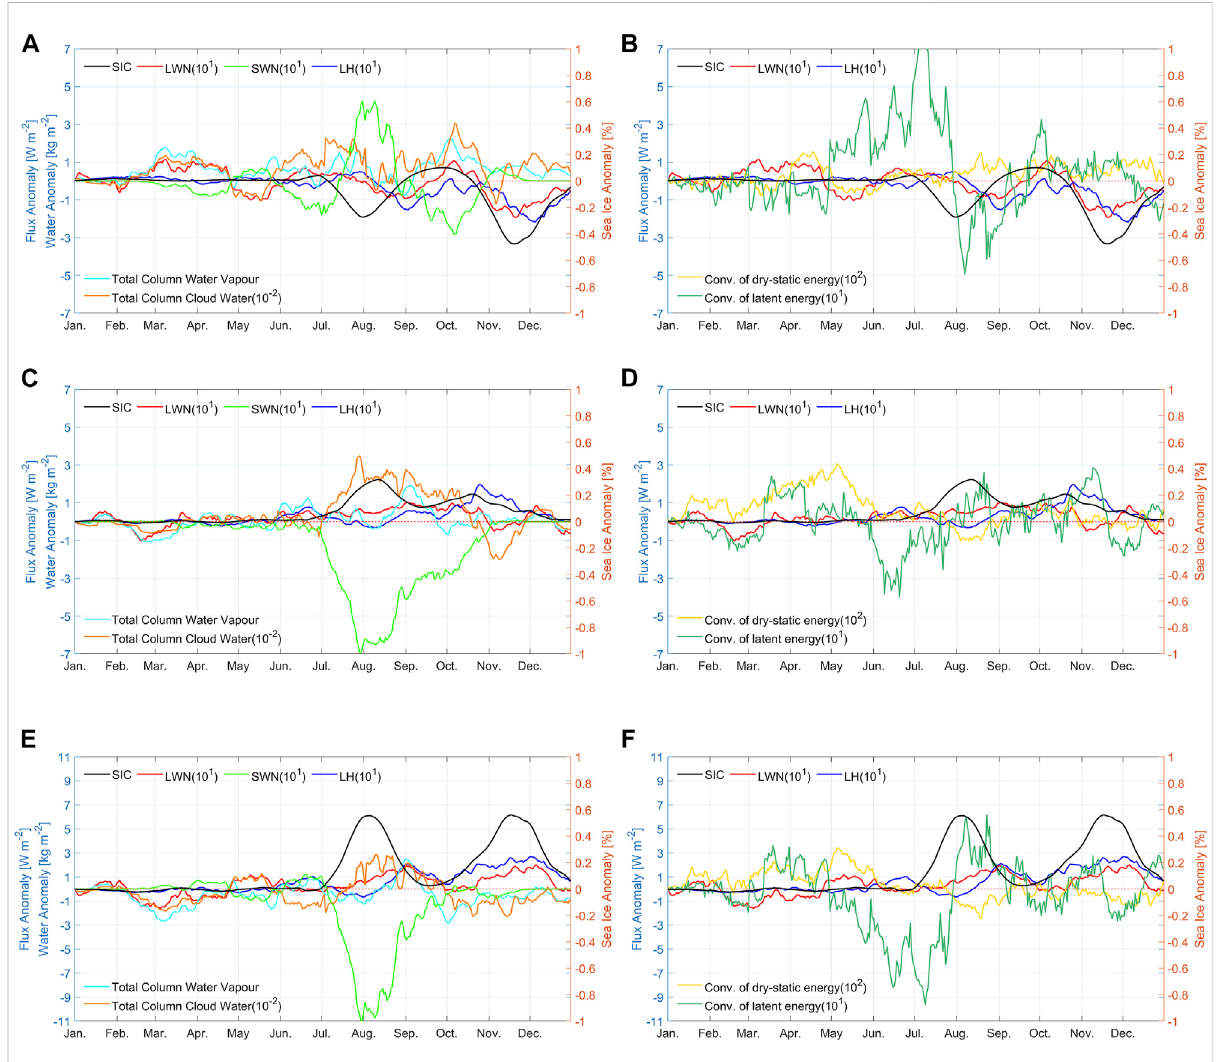
FIGURE 5 Atmospheric water content and energy convergence anomalies for 2019 [top, (A,B) ], 2020 [middle, (C,D) ] and 2020 minus 2019 [bottom, (E,F) ] using method one. The black line shows the SIC (right – hand axis). (A,C,E) , the net longwave radiation (red), the net shortwave radiation (green) and latent fl ux (blue) are shown together with the anomalies of total column cloud water (liquid plus solid; orange) and water vapor (celeste), (B,D,F) , as well as the convergence of dry-static (gold) and latent atmospheric energy transport (prasinous).